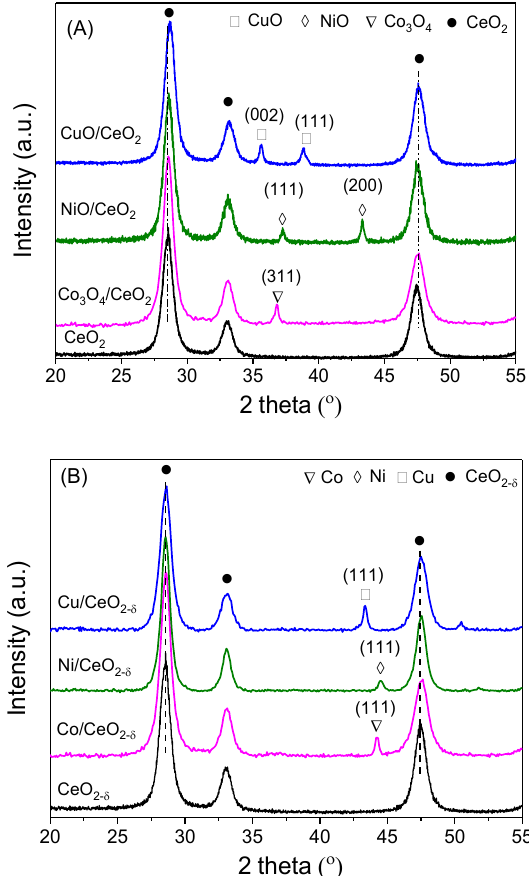
Figure 1. XRD pattern of ( A ) the MO x /CeO 2 precursors and ( B ) the M/CeO 2 − δ catalysts (M = Co, Ni, Cu, respectively). Table 1. The properties of the MO x /CeO 2 precursors and corresponding M/CeO 2 − δ catalysts.